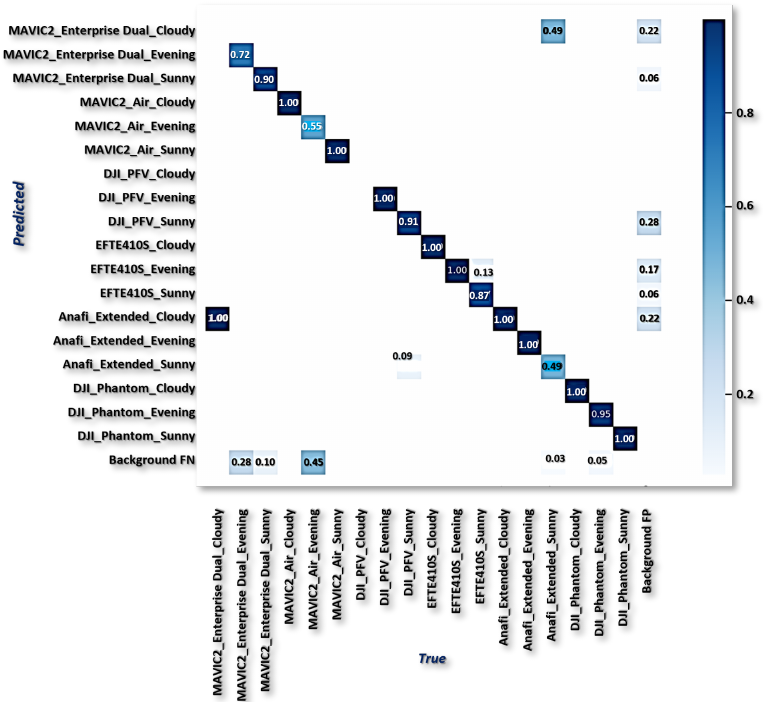
Figure 17. ALIEN confusion